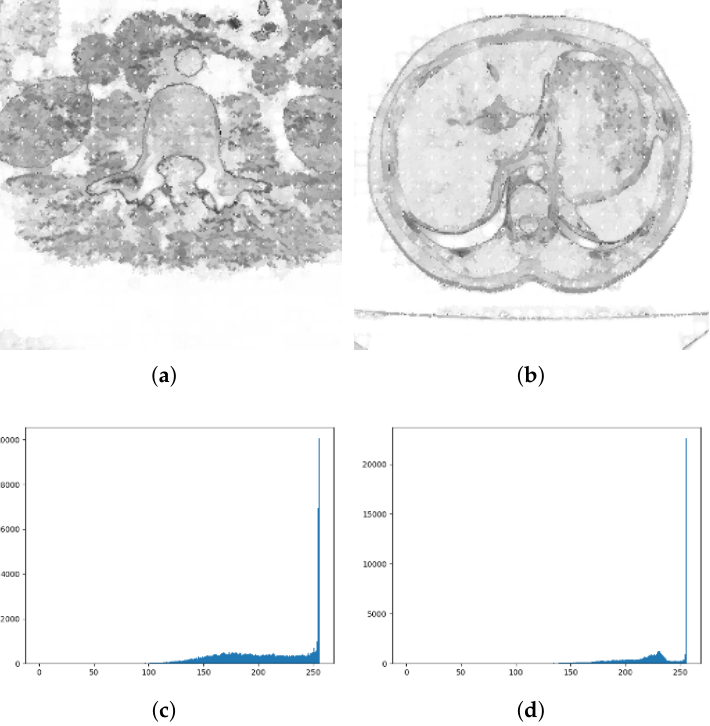
Figure 3. Grayscale image and corresponding parameter statistical histogram. ( a , b ) represent the grayscale image after adaptive parameter transformation. The white dot in the image represents the center of the super pixel; ( c , d ) represents the grayscale histogram of this